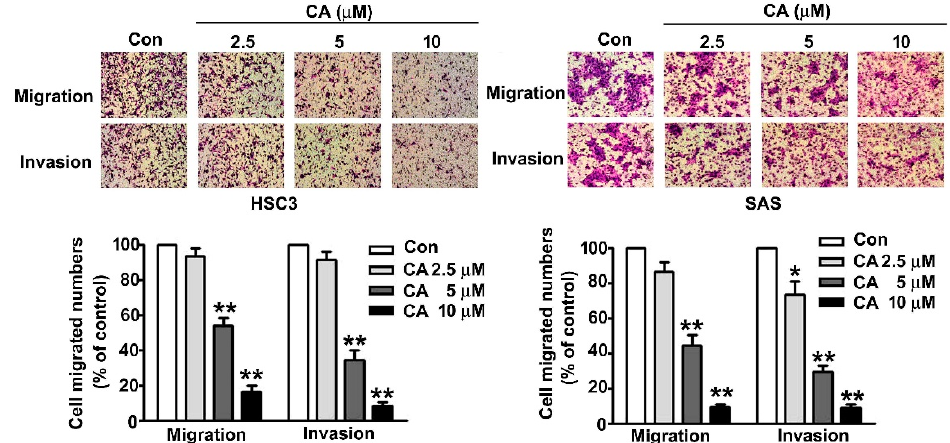
Figure 3. Effect of CA on cell migration and invasion of human HSC3 and SAS OSCC cells. Human HSC3 and SAS cells were treated with various concentrations of CA (0, 2.5, 5 and 10 µ M) for 24 h, and then, capacities of cellular migration and invasion were measured. *, p < 0.05, **, p < 0.01 vs. control (line 1), (Mean ± SE, n = 3). Control: untreated cells. Scale bars: 50 μ m.